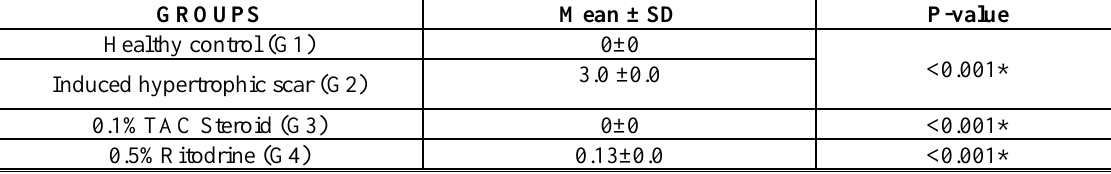
Table 4.Mean scar size score in control and study groups GROUPS